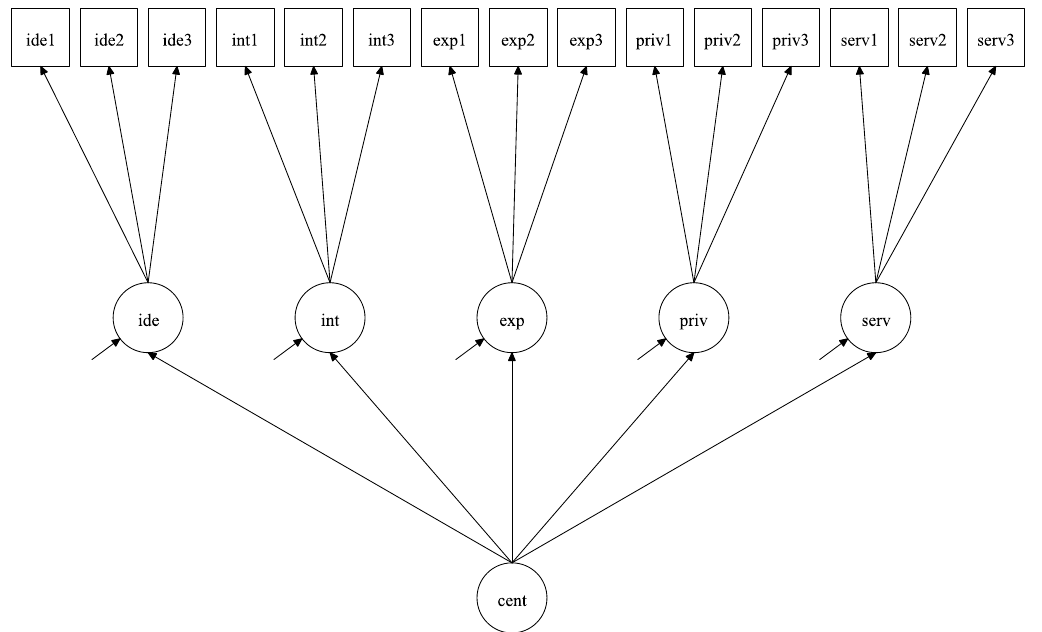
Figure 5. The confirmatory factor analysis model for the CRS-15. int = intellect; ide = ideology; serv = public practice; priv = private practice; exp = experience. The number after the item name indicates the position of the item within the core dimension items. Squares depict manifest and circles latent variables. Residual arrows are not shown for the manifest variables. Residuals for the latent variables are shown as arrows starting in blank space.